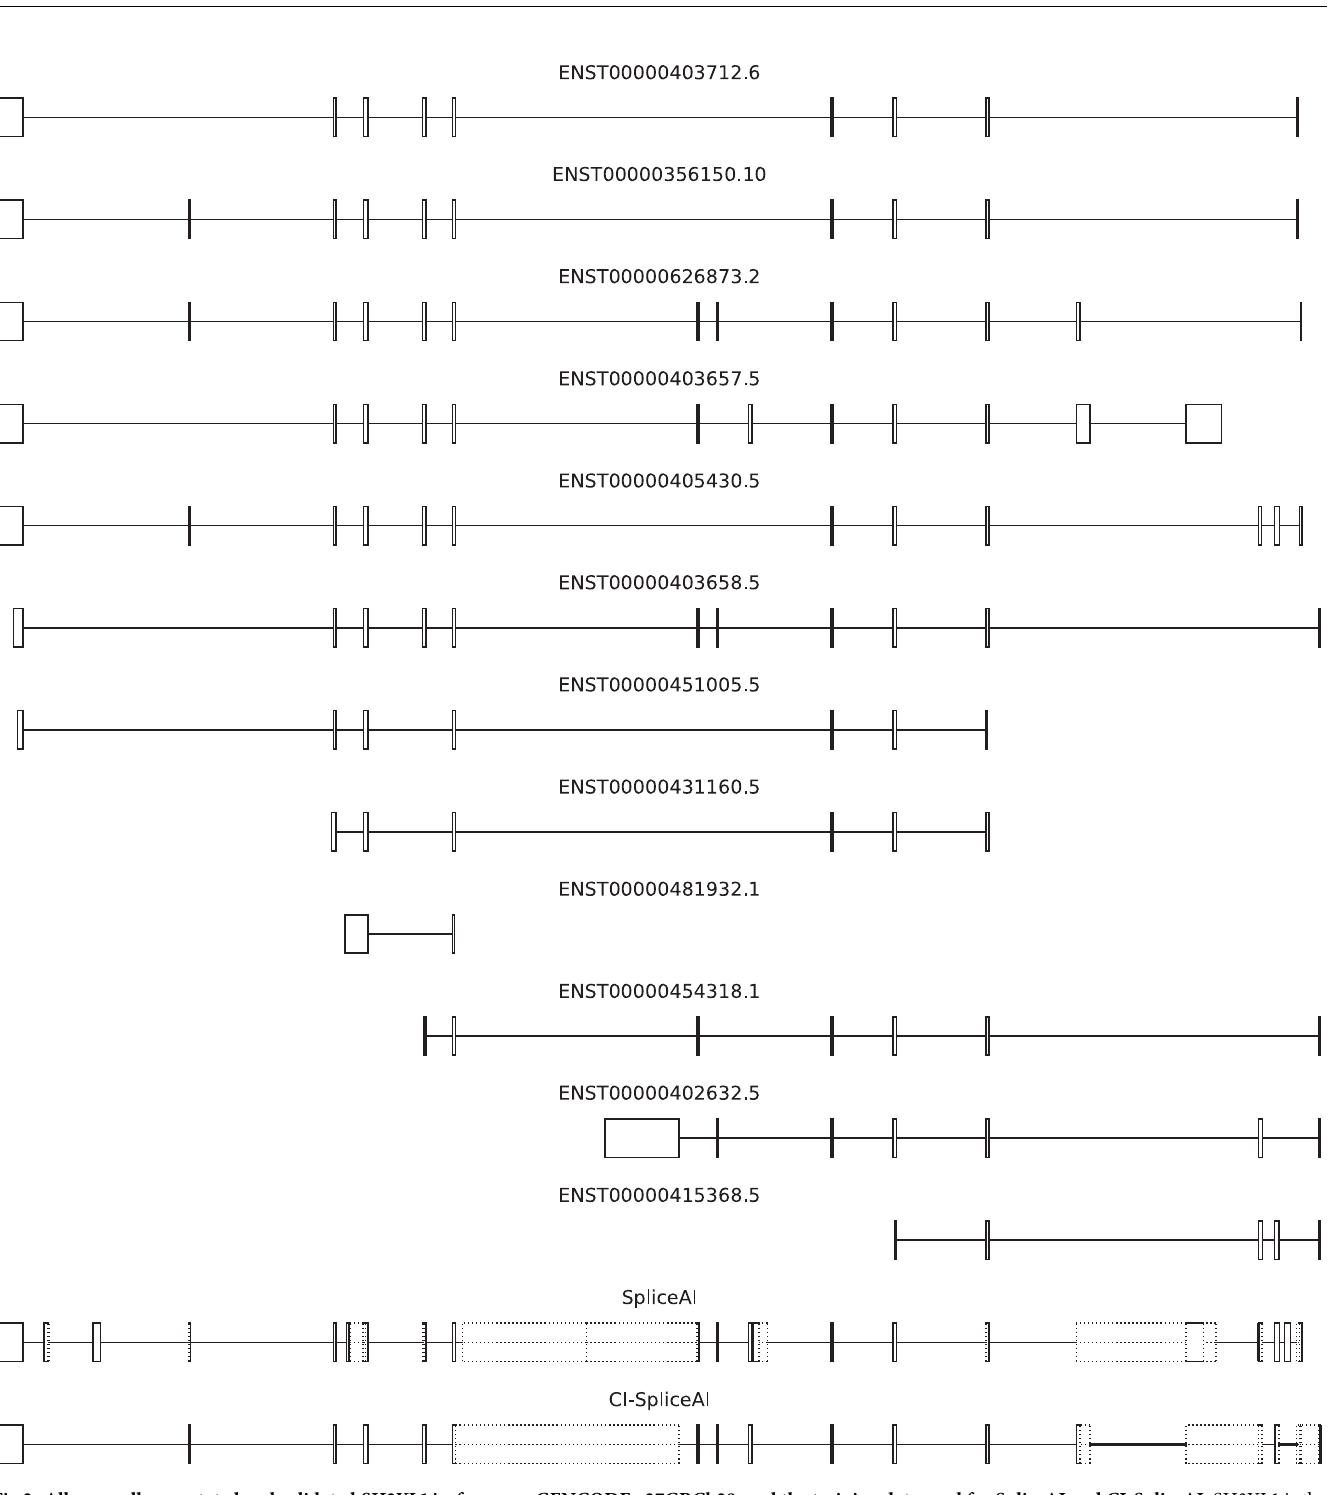
Fig 2. All manually annotated and validated SH3YL1 isoforms on GENCODE v37GRCh38, and the training data used for SpliceAI and CI-SpliceAI. SH3YL1 is the first gene on the SpliceAI training data with more than one validated transcript. Ambivalent regions that can code for both exons and introns are depicted by dotted lines. On this gene, 26 (46%) of splice sites in the SpliceAI training data are not in HAVANA; 7 (18%) of our splice sites are not present in SpliceAI training data.